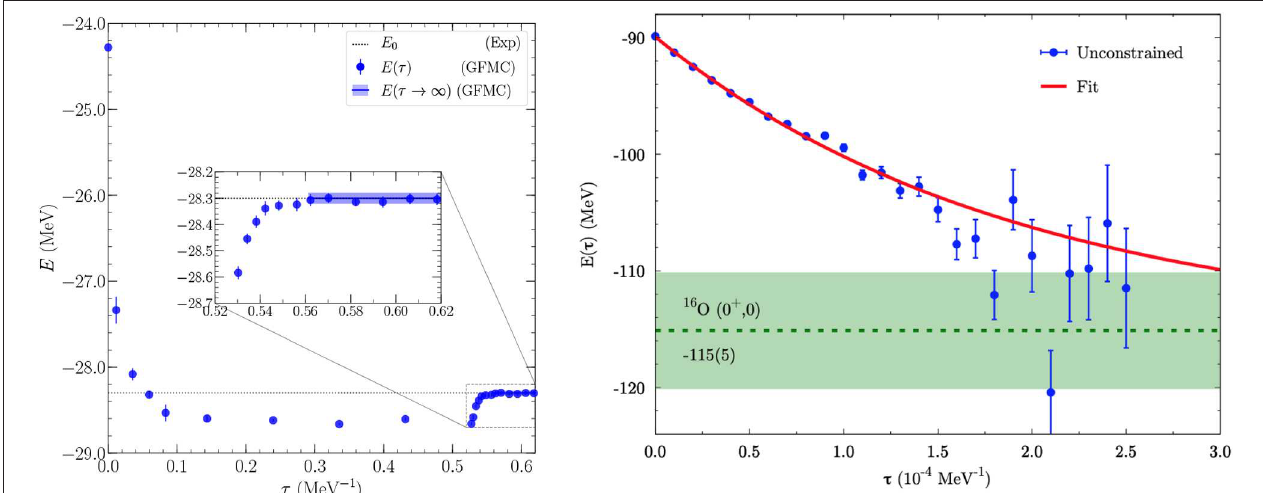
FIGURE 3 | Left : The imaginary time evolution for the ground state energy of 4 He in the GFMC method using the local chiral two- and three-nucleon interactions of Gezerlis et al. [87], Gezerlis et al. [88], and Lynn et al. [3] at cutoff R 0 1.0 fm. The figure shows the constrained evolution, i.e., an evolution where the nodal surface is = fixed, while the inset shows the unconstrained evolution. Reprinted figure with permission from Lynn et al. [ 89]. Copyright 2017 by the American Physical Society. Right : The unconstrained evolution for the ground-state energy of 16 O in the AFDMC method (blue points) using the same local interactions. The red line represents an exponential fit to the data to extrapolate to the final result (green band). Reprinted figure with permission from Lonardoni et al. [ 90]. Copyright 2018 by the American Physical